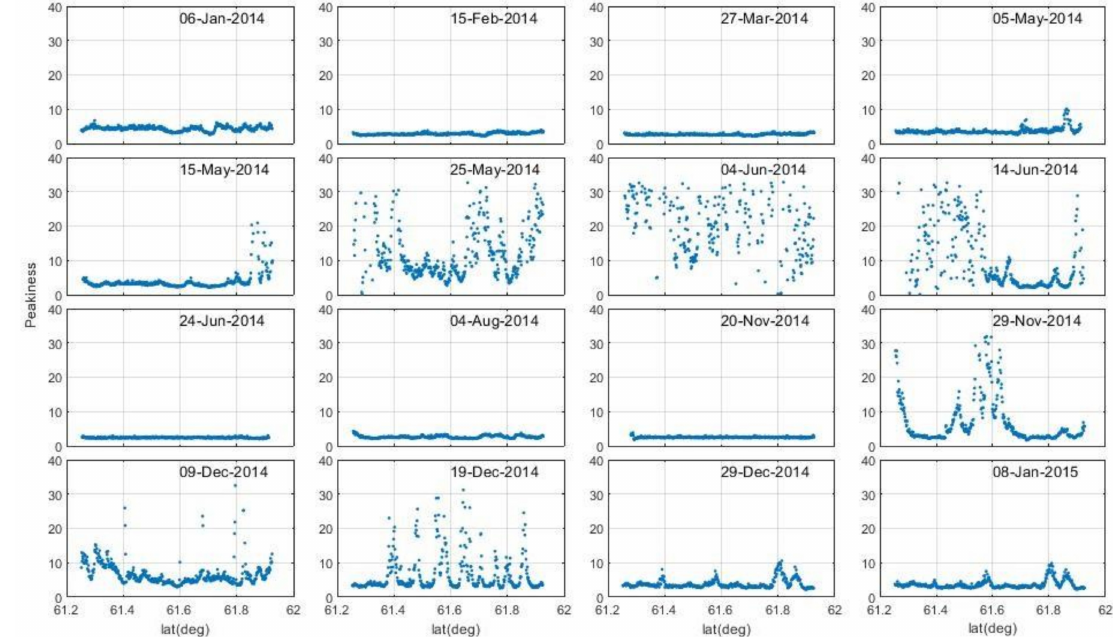
Figure 4. Profiles of peakiness along Jason-2 track 045 over Great Slave Lake from January to December